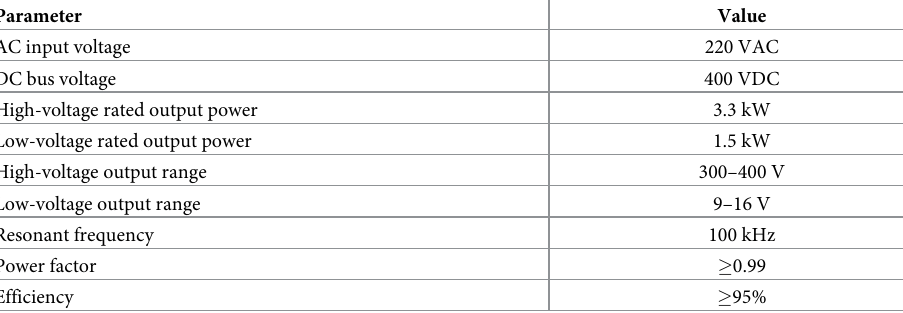
Table 2. Design metrics for integrated